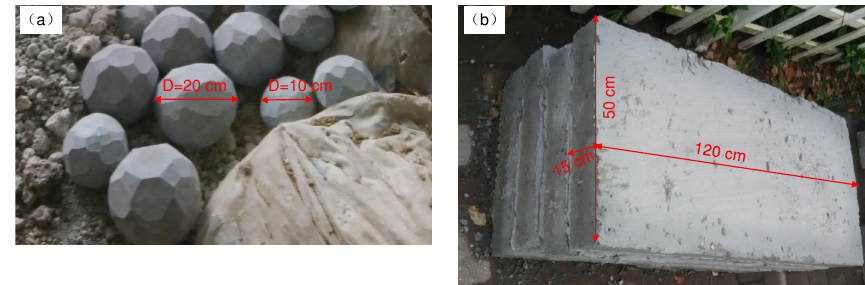
Figure 2. Materials used in this experiment: (a) spherical limestone polyhedron with two diameters and (b) C25 prefabricated concrete